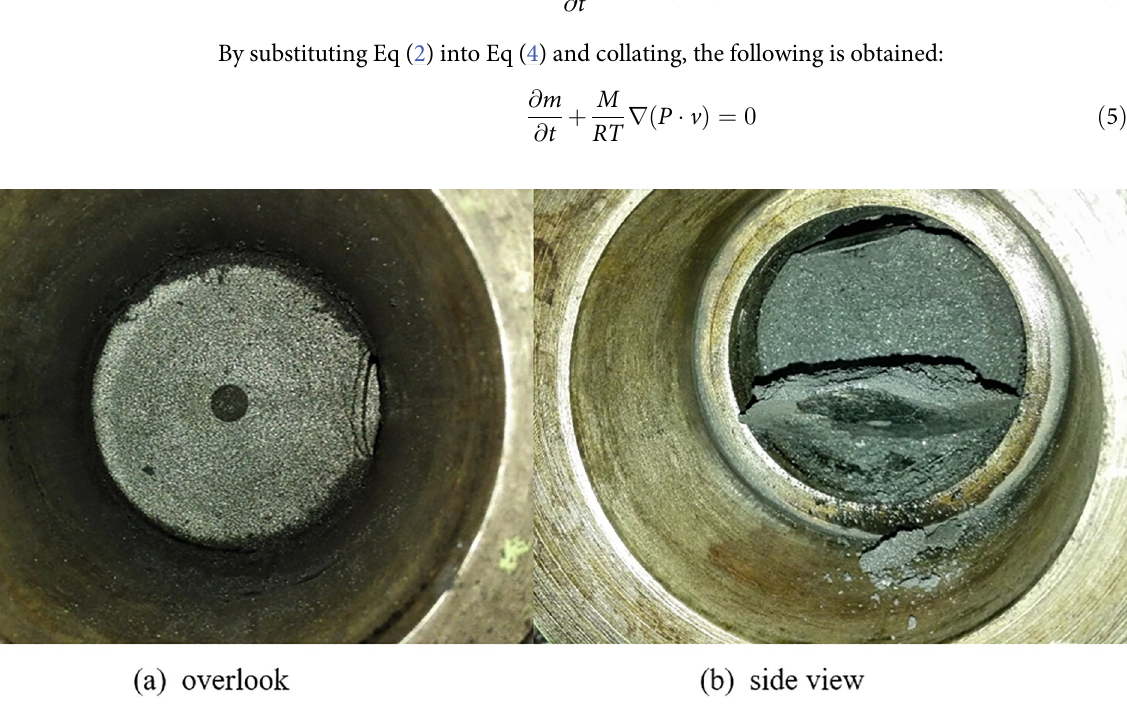
Fig 4. Damage phenomenon after pressure relief in the case of non-adsorbed